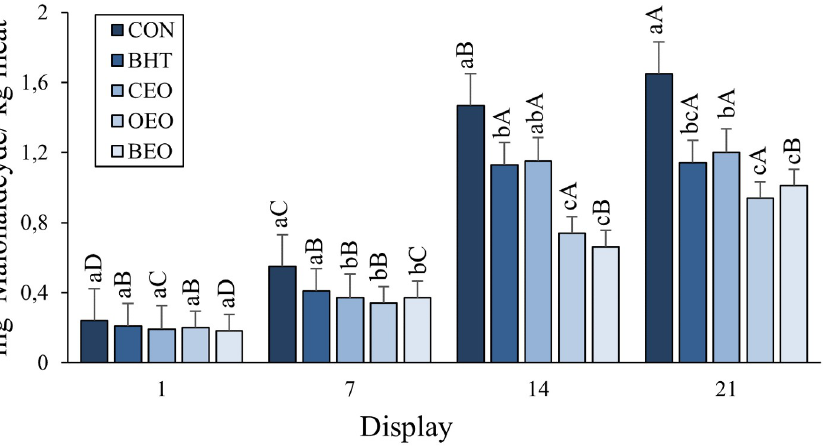
Fig 2. Evolution of lipid oxidation in beef patties treated with BHT, copaiba and oregano essential oil or blend of essential oils during display.